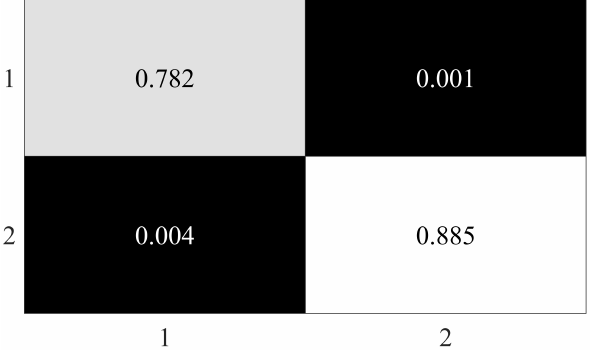
Figure 25. MAC matrix between experimental and numerical